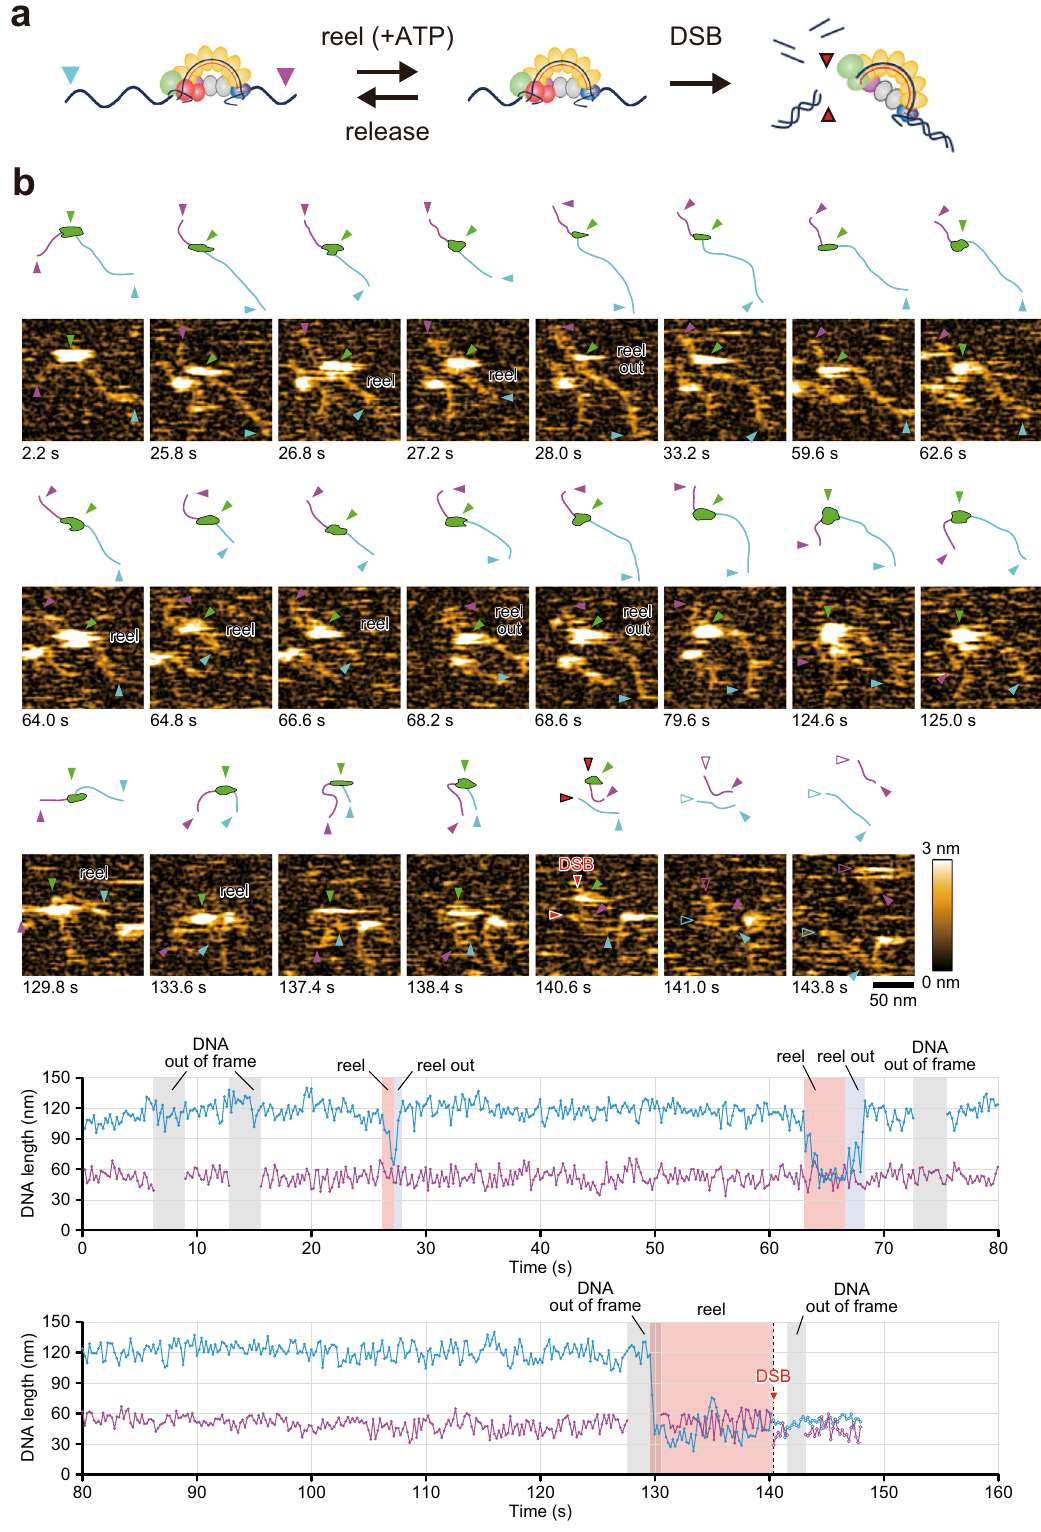
Fig. 5 | Visualization of type I CRISPR interference. a Schematic depictions of type I CRISPR interference. b In ATP (+) reaction buffer, the EcoCas3-Cascade complexrepeatedlyreelsandreleasesthelongersideoftheDNA(bluearrows)and